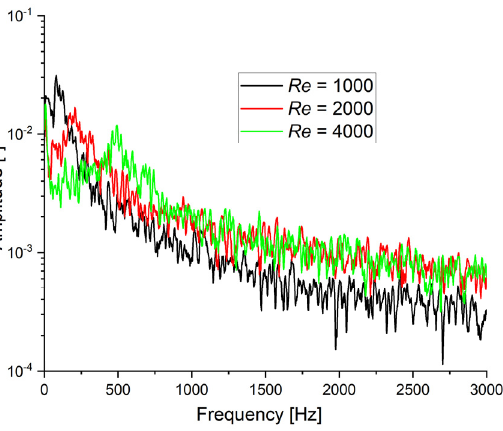
Figure 12. Frequency spectra of air-core diameter fluctuations at location d ac11 . Experimental data.